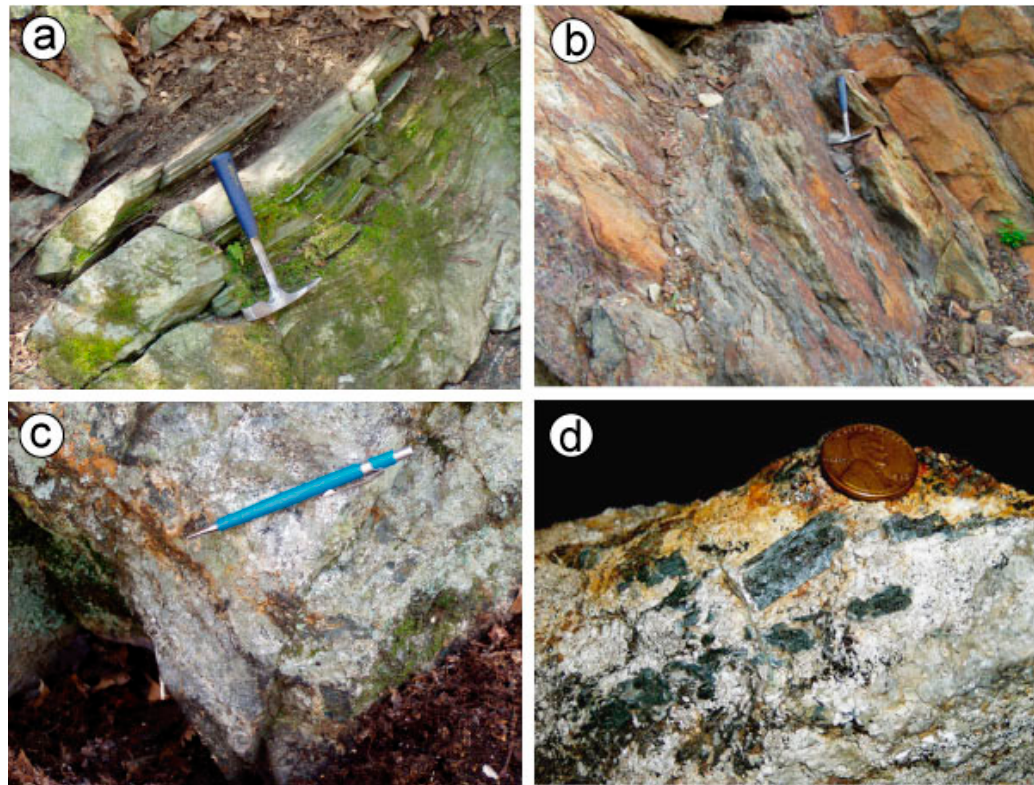
Figure 2. Field photographs of representative types of biotite gneiss in the New Jersey Highlands. ( a ) Interlayered sequence of pale pinkish-white metapelite (above hammer handle) and metagraywacke (beneath hammer head). Photograph is oriented SW (left) to NE (right). ( b ) Rusty graphitic biotite gneiss similar to that hosting prismatine + kornerupine at Mase Mountain. Photograph is oriented W (left) to E (right). Hammer is 33 cm. ( c ) Pale pinkish-white kornerupine-bearing metagraywacke from Ringwood. Photograph is oriented NW (left) to SE (right). Pencil is 14.5 cm. ( d ) Close-up of dark green, rectangular kornerupine crystals from Ringwood (below coin; 1.9 cm), the longest of which is 2.5 cm. Other minerals include quartz, oligoclase, microcline, and biotite. Note the occurrence of kornerupine in coarse-grained leucosome, and gradational contact between leucosome and host gneiss in lower right of